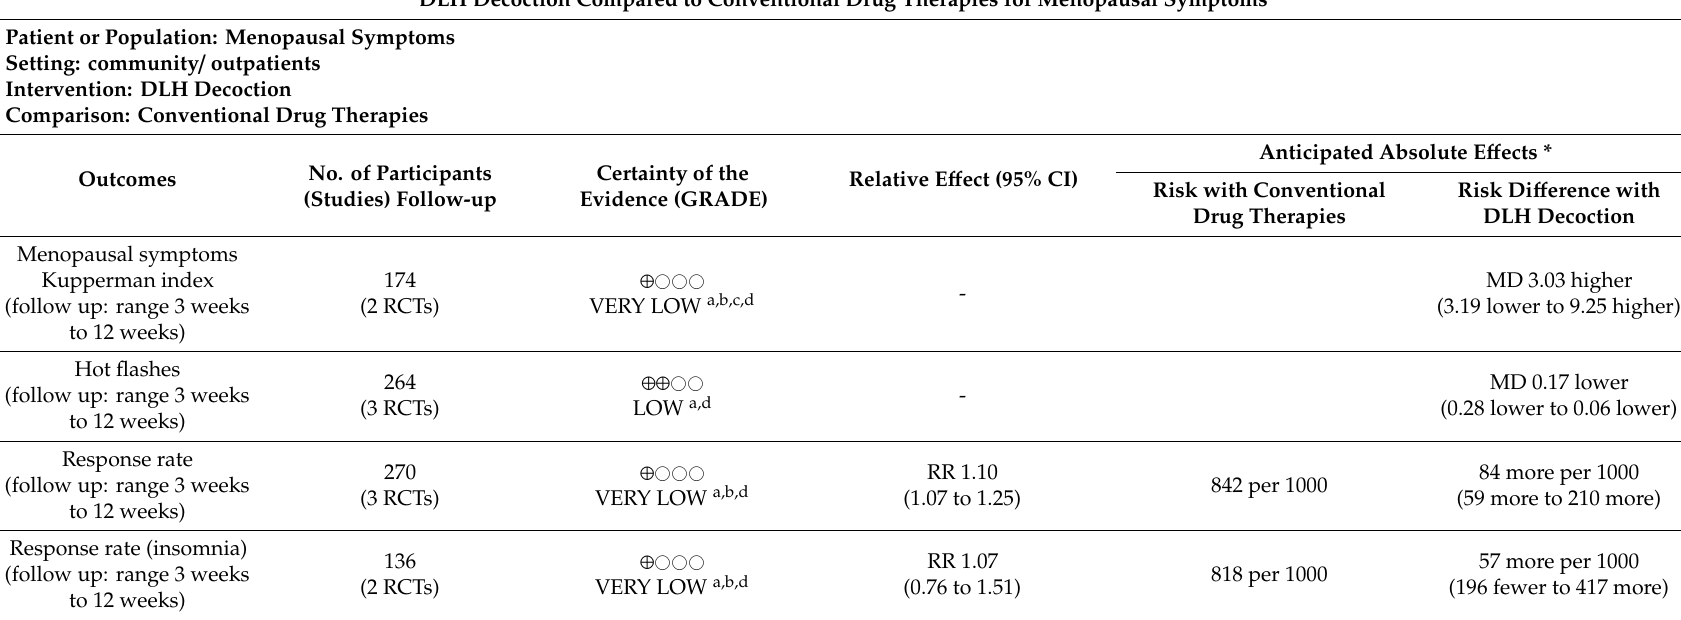
Table 2. Summary of